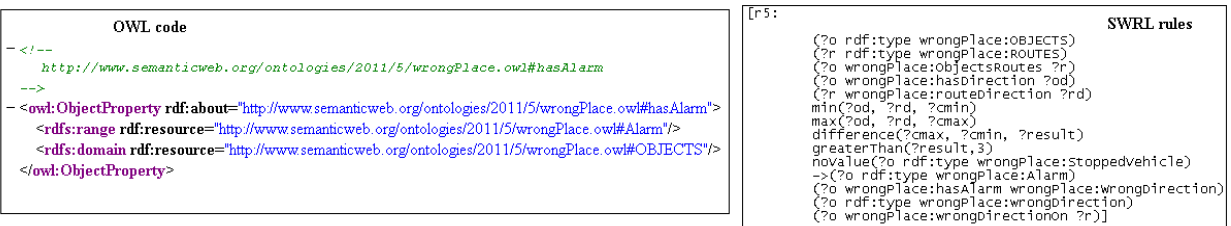
Figure 3. OWL and SWRL code.